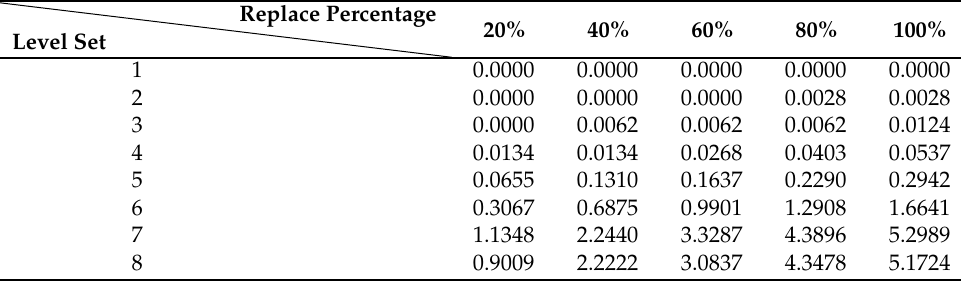
Table 14. Pressure error of substituting the 7th